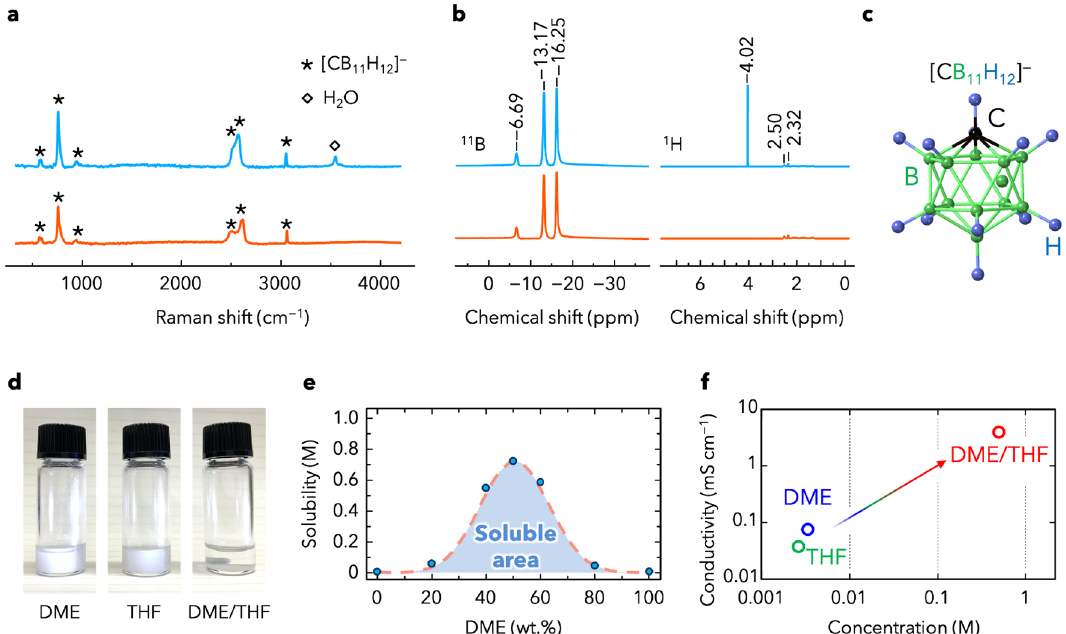
Figure 1. ( a ) Raman spectra of calcium monocarborane (CMC) (orange) and CMC·nH 2 O (blue). ( b ) 11 B and 1 H nuclear magnetic resonance (NMR) spectra of CMC (orange) and CMC·nH 2 O (blue). ( c ) Geometry of the [CB 11 H 12 ] – anion (black, green, and blue spheres denote C, B, and H atoms, respectively). ( d ) Photographs of CMC dispersed/dissolved in 1,2-dimethoxyethane (DME), tetrahydrofuran (THF), and a DME/THF mixture. ( e ) Solubility diagram of CMC in mixtures of DME/THF with various solvent ratios. ( f ) Relationship between conductivity and CMC solubility (for details, see Table S2 and Fig. S2). The thermal stability is shown in Fig. S4. The conductivity of the solid phase CMC were measured by EIS and shown in Fig.